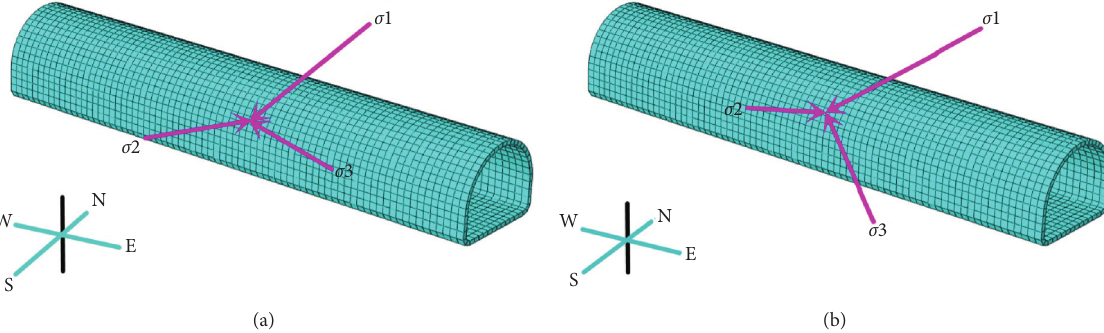
Figure 3: Relationship between main direction of ground stress and tunnel axis. (a) Left tunnel. (b) Right tunnel. Table 1: Test results of ground stress in Longxi Tunnel (updated from Xu et al. [31]). Location of test